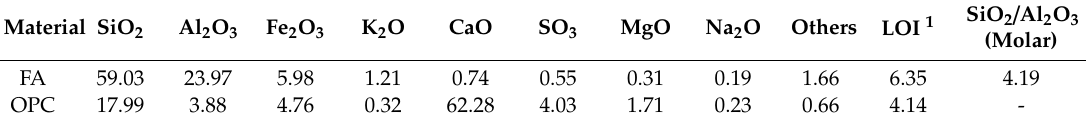
Figure 1. Particle size distribution curve of the fly ash (FA) and Portland cement (OPC). Table 1. Chemical composition of the raw materials (%).